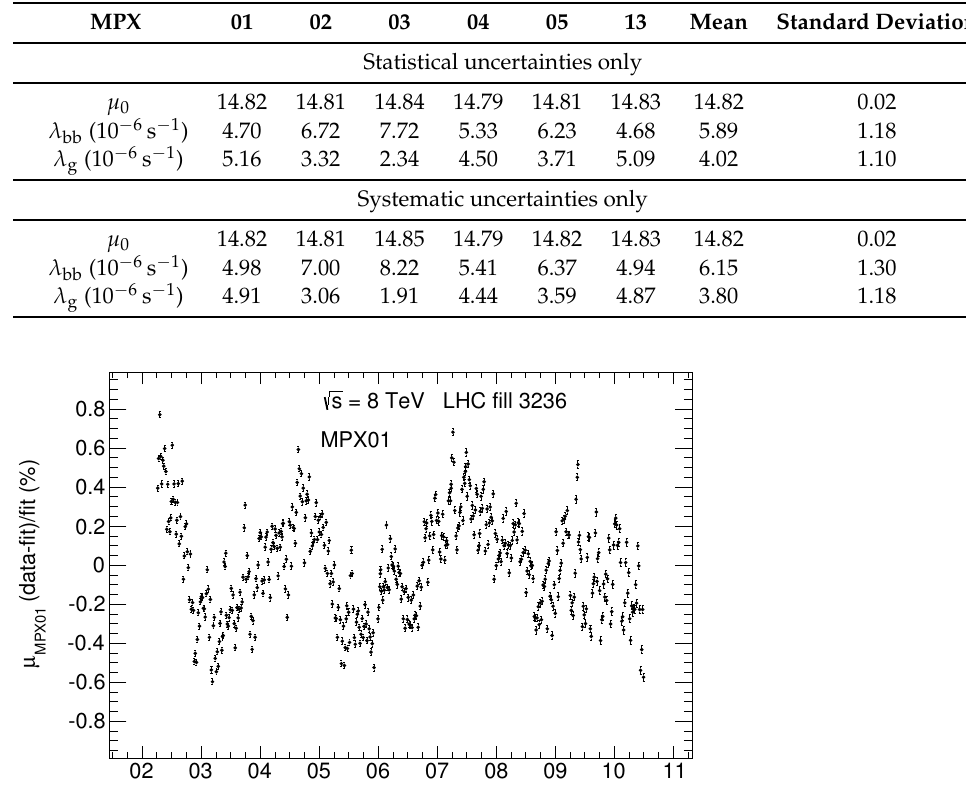
Table 7. Fit values of µ 0 , λ bb and λ g for the MPX devices with highest particle flux for statistical uncertainties only, and for systematic uncertainties only, constant in time, such that χ 2 /ndf = 1. LHC fill 3236. See Section 2.5 for the details. Taken from Ref. [11].